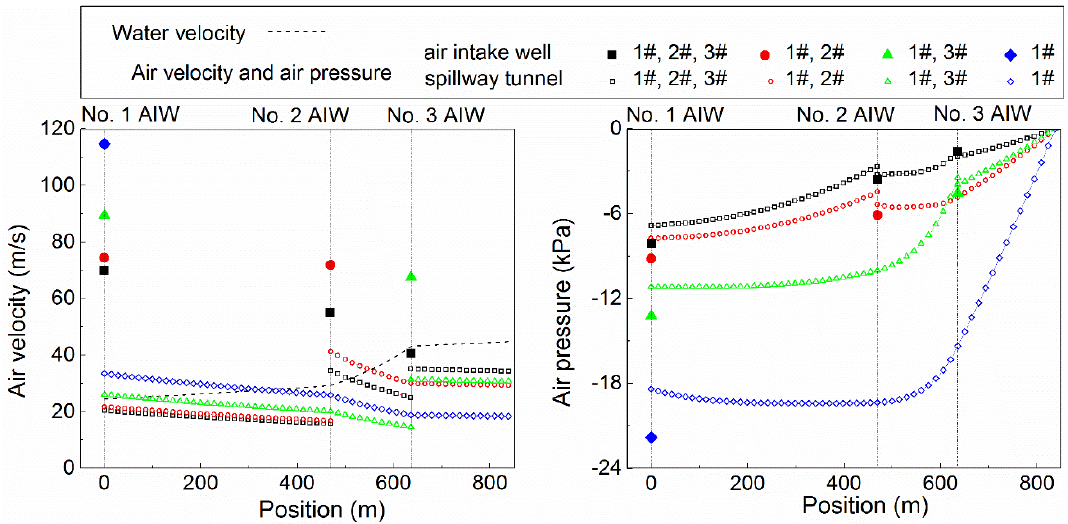
Figure 10. Influence of the number of air intake wells on the ventilation characteristics.